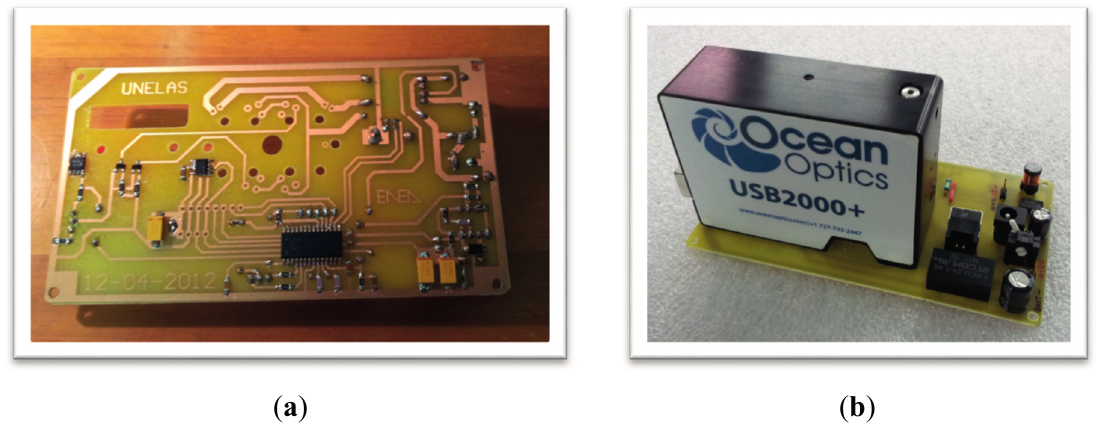
Figure 6. Detail of the electronic assembly: ( a ) printed circuit board; ( b ) assembled sensor.